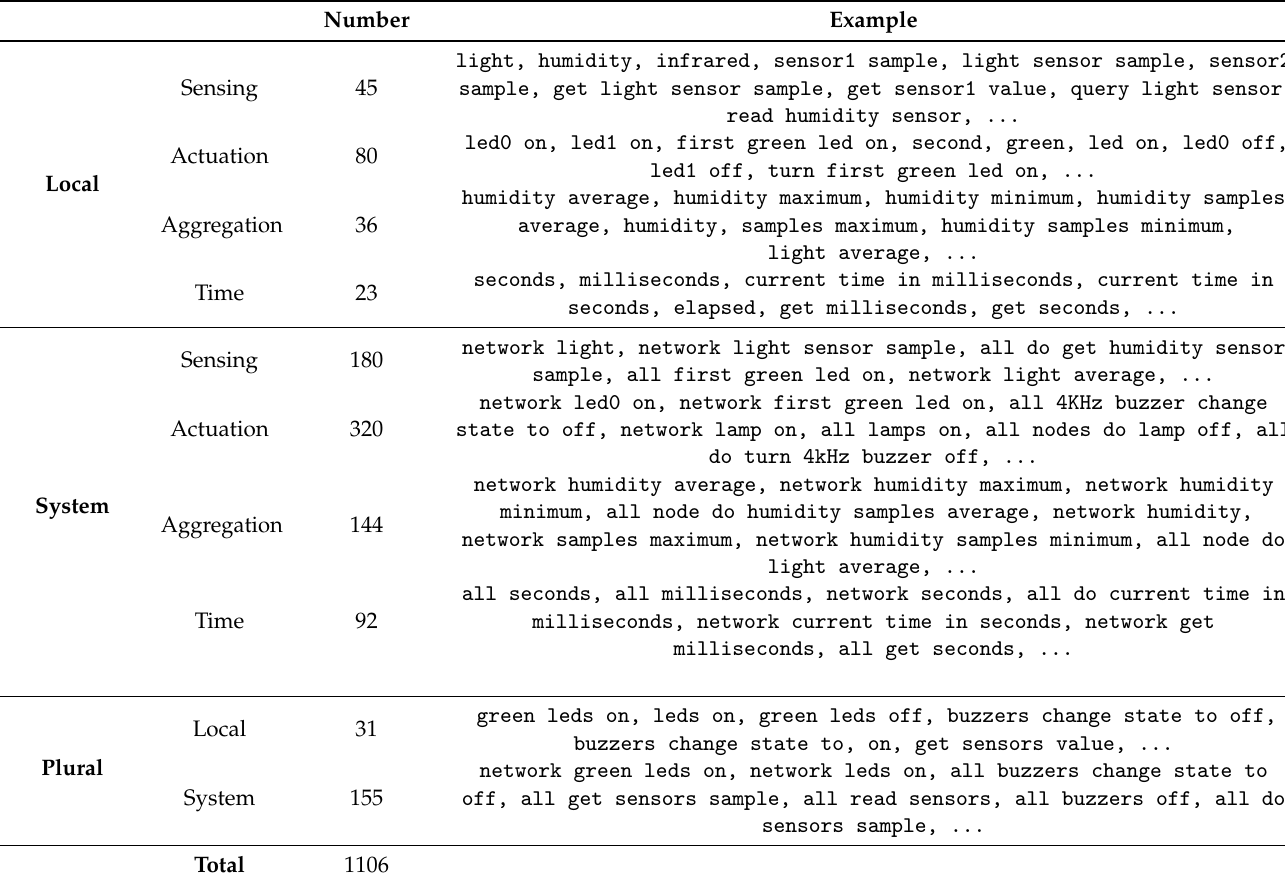
Table 1. Executable sentences for the test knowledge base.